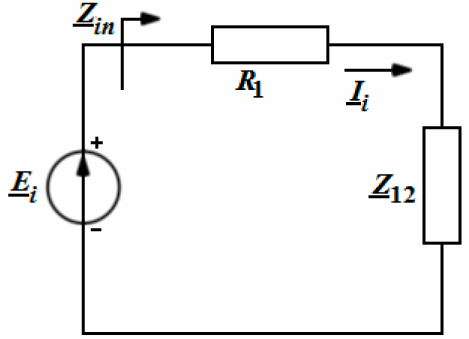
Figure 3. Equivalent